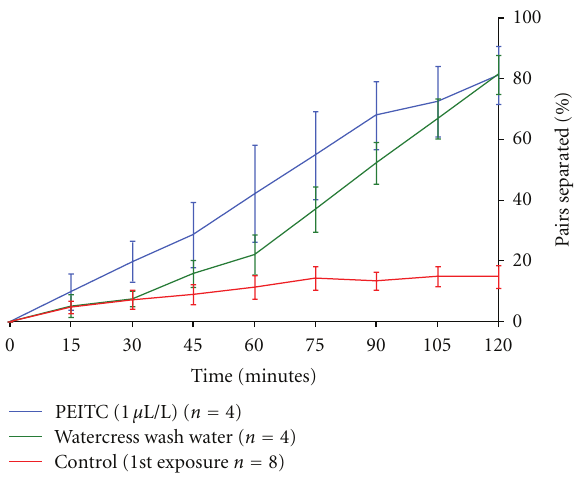
Figure 1: Mean cumulative proportion of pairs separated ( ± SE). Precopular pairs were exposed at Time = 0, the mean of 4 tests over the course of the 2 h exposure is shown for each test substance (carried out on separate occasions, with a total of 119 pairs exposed to wash water, 105 pairs exposed to PEITC) and the control (mean of 8 tests, with a total of 157 pairs exposed). Vertical bars show standard error; n denotes the number of tests. There was immediate separation of at least one pair in all the PEITC test solutions (i.e., by the first 15-minute reading). There was separation of at least one pair in all the watercress wash water test solutions after 45 minutes. There was a steady increase in the number of pairs separated over the course of the two-hour test to 70% or greater in all wash water test solutions (maximum 95%, mean 84%) at the test end. The pattern of response for the PEITC solution was very similar (maximum 100%, mean 85%) at test end.